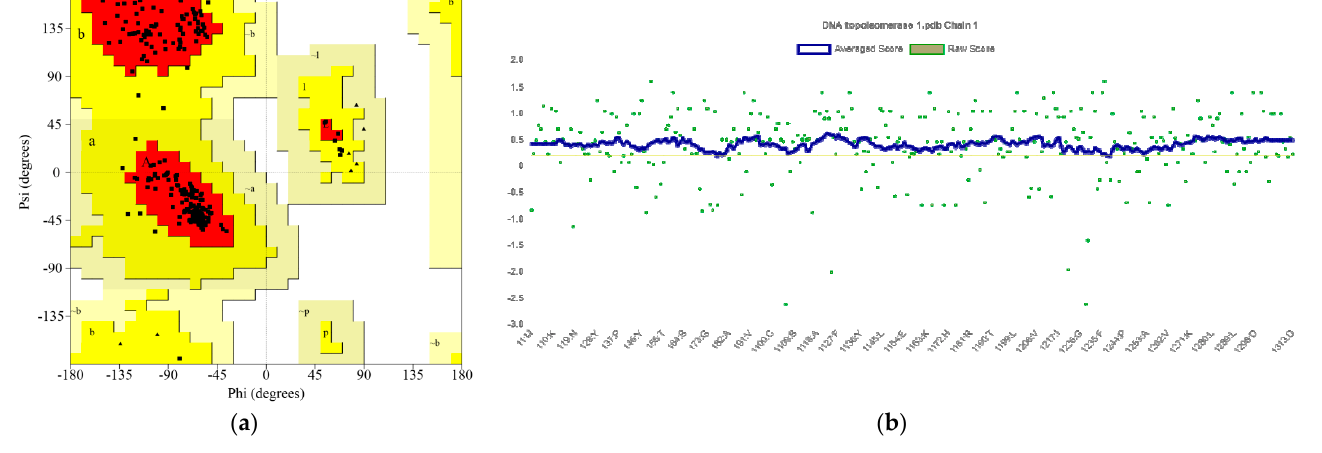
Figure 2. ( a ) Ramachandran plot towards TOP1 model; ( b ) results of the Verify_3D analysis of the TOP1 model.